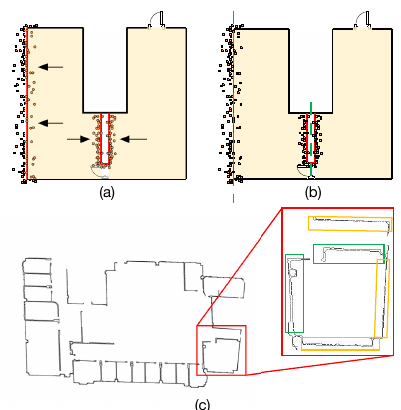
Figure 5. The illustration of points distributions. a), b) Scanning process: the black arrows indicate the directions of the scanning, showing different point distributions on outer and inner walls. c) The points distributions on the real data, inner walls (green rectangles) and outer walls (yellow rectangles) We calculate two weights for each line taking outer and inner walls into account. Figure 6 indicates two different patterns